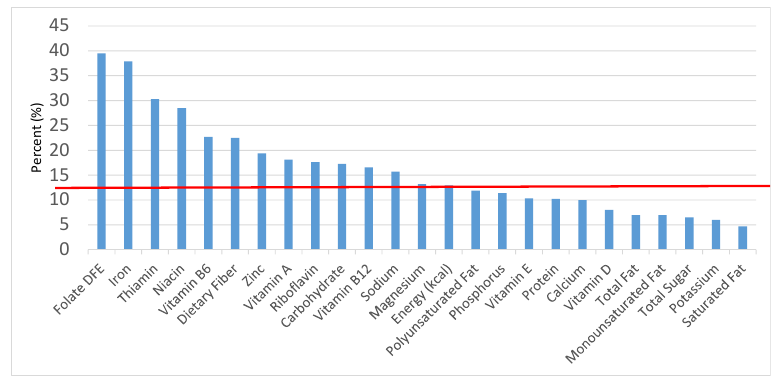
Figure 2. Grain foods sources of energy and nutrients for children 1–3 years old ( N = 1423, daily intake data): DFE = Dietary Folate Equivalents; solid red line represents percentage of energy (kcal) provided in the diet relative to nutrients—nutrients above the red line show the grain food’s contribution to nutrient density.